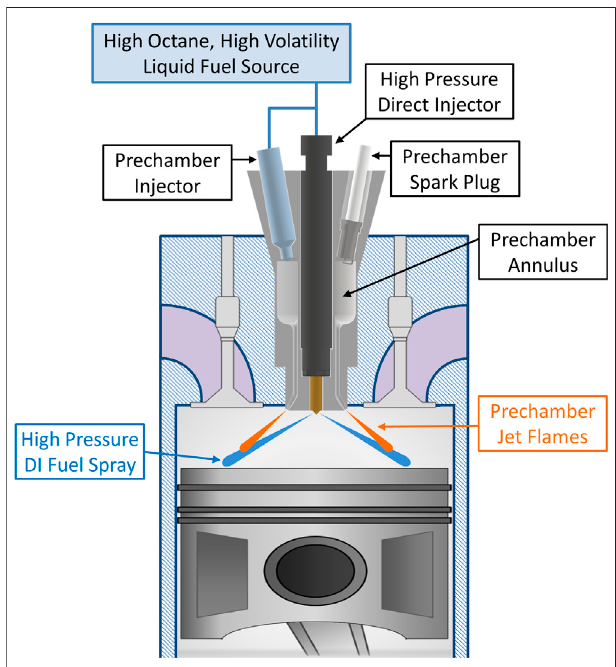
FIGURE 1 | Prechamber enabled mixing controlled combustion (PC-MCC)